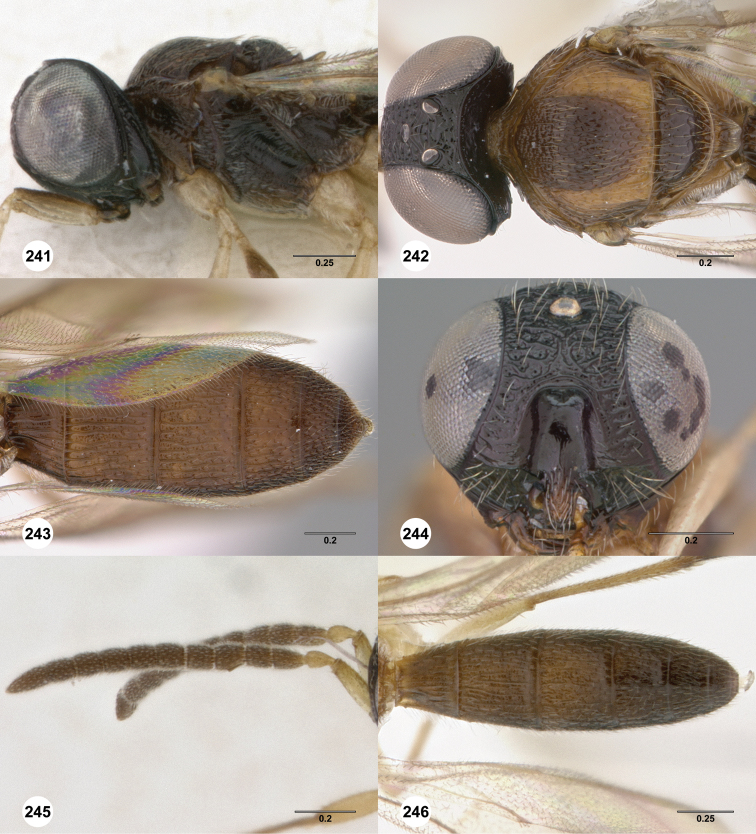
Oxyscelio oculi sp. n., holotype female (OSUC 442277) 241 Head and mesosoma, lateral view 242 Head and mesosoma, dorsal view 243 Head, anterior view 244 Metasoma, dorsal view. Paratype male (OSUC 442295) 245 Antenna 246 Mesosoma, dorsal view. Morphbank74